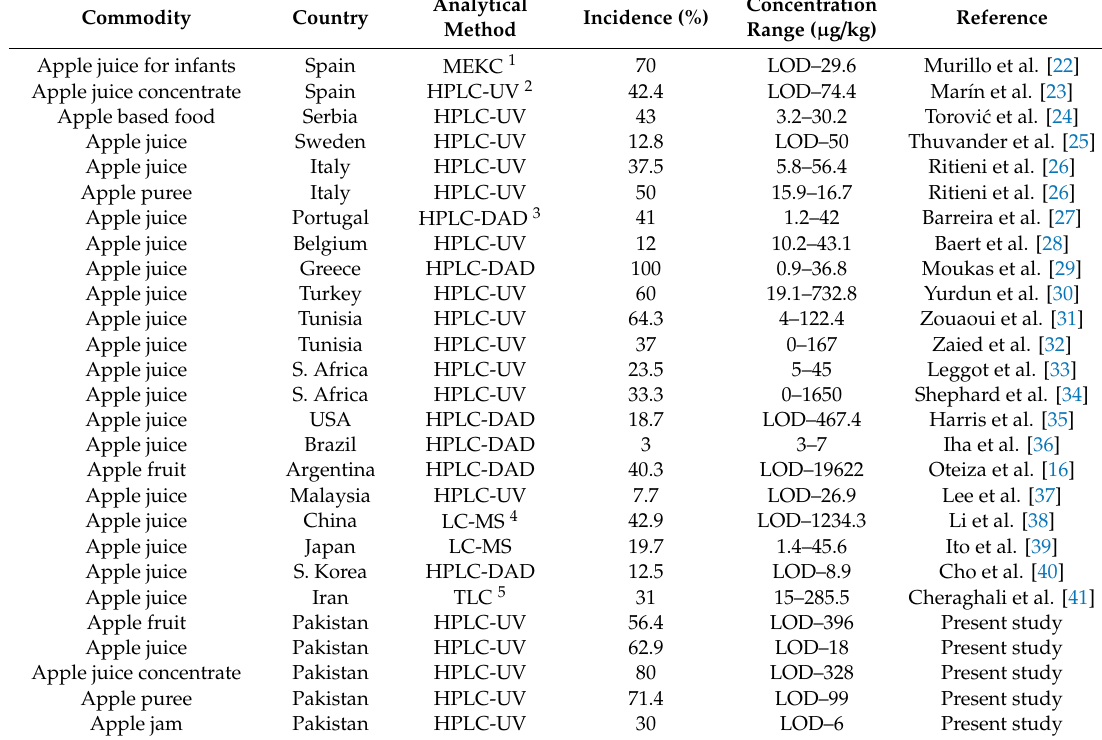
Table 2. A summary of studies on PAT occurrence in apple fruits and derived